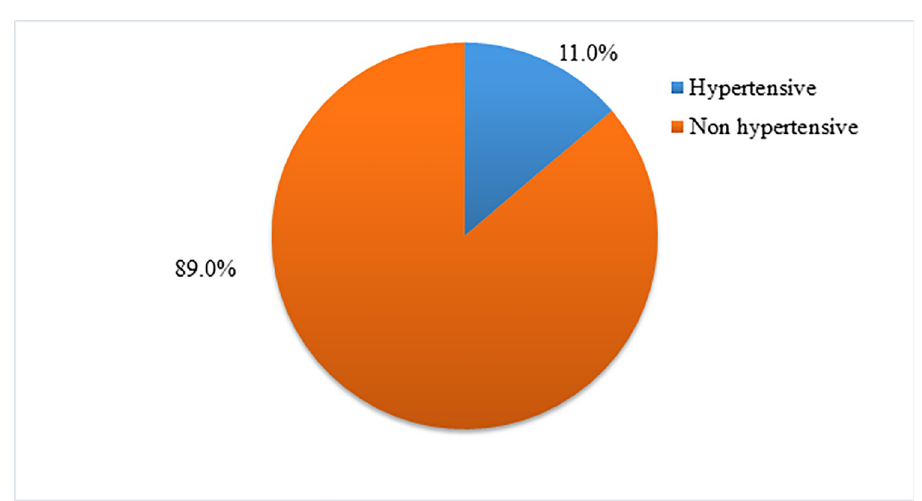
Fig 2. The magnitude of hypertension among clients on HAART at NEMMRH from January 20-March 20, 2020.